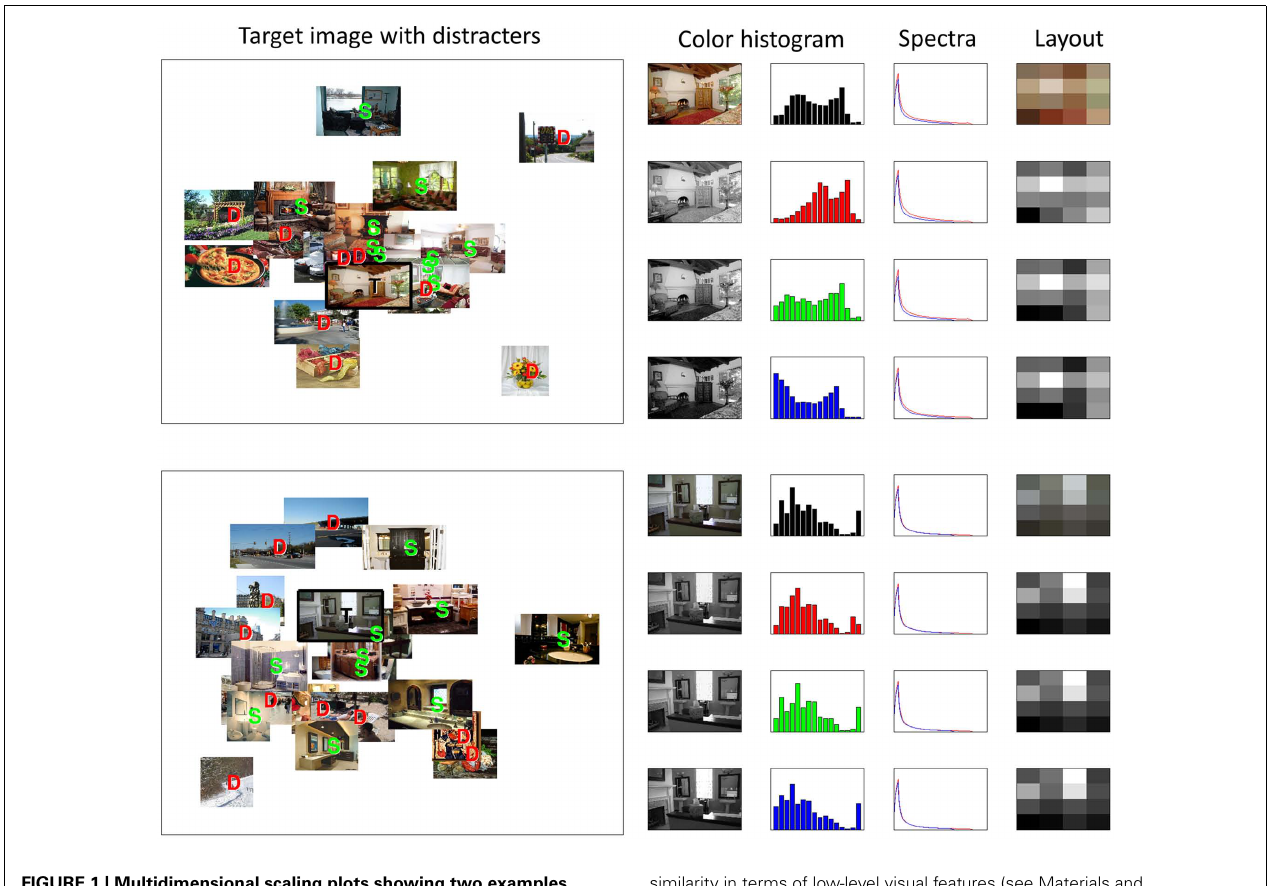
FIGURE 1 | Multidimensional scaling plots showing two examples of target images (outlined in black rectangle and marked with “T”), similar distracters (marked with “S”), and different semantic category distracters (labeled with “D”). Distances represent